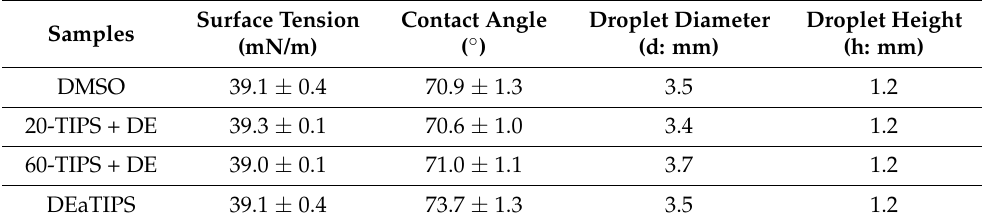
Table 1. Surface tension and shape parameters of different samples.